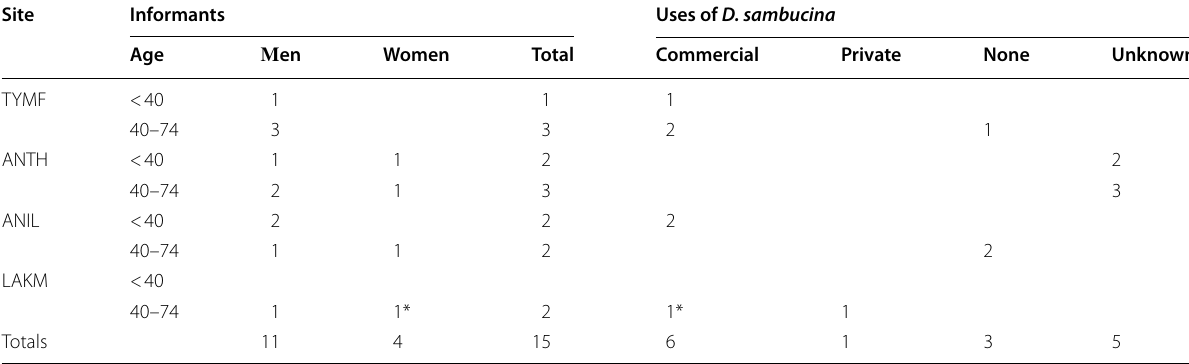
Each line represents answers by one demographic category and how they use D. sambucina . The asterisk (*) refers to a woman who collected commercially in the past, but not currently. Note that “None” in column 8 means that the informants could identify the species but they do not collect